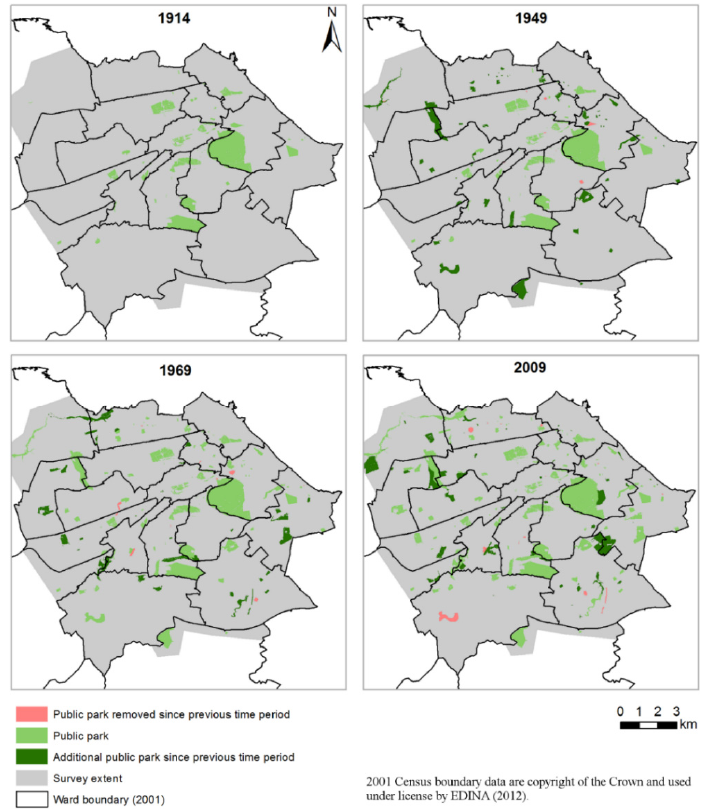
Figure 1. Mapping the public parks in Edinburgh in 1914, 1949, 1969 and 2009.